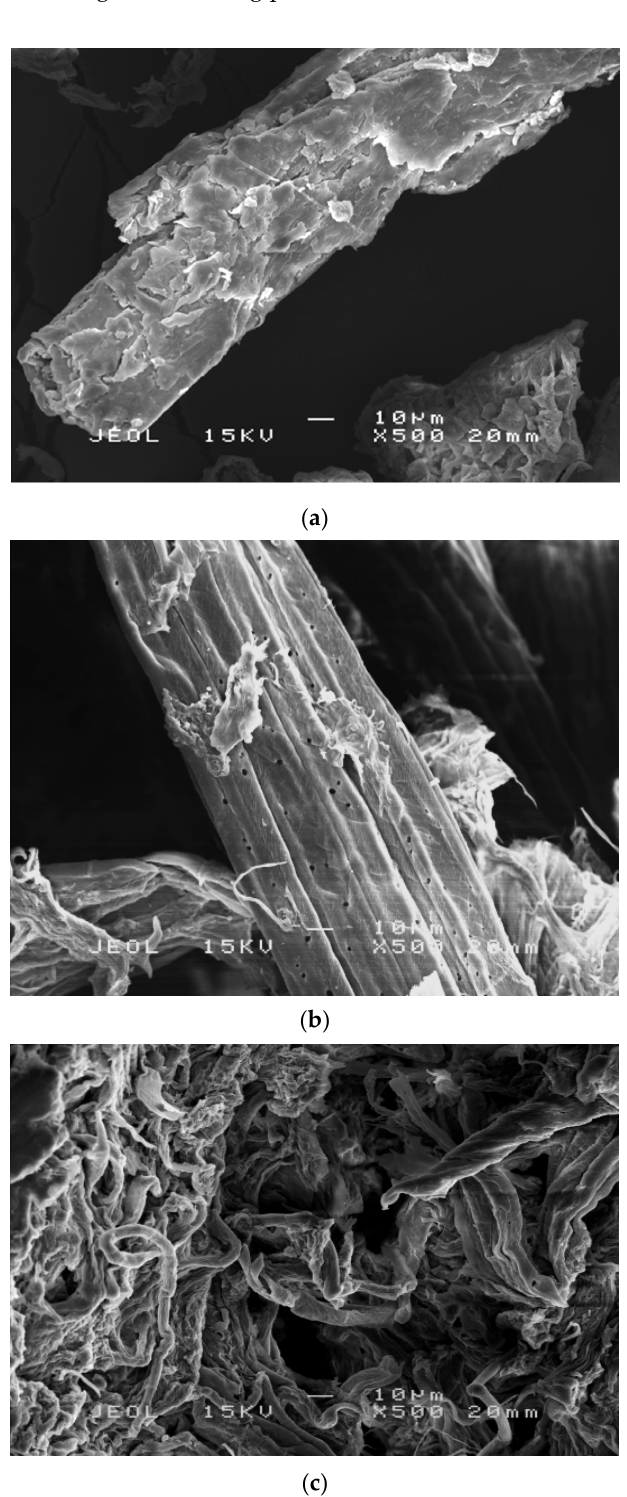
Figure 4. SEM micrographs of ( a ) raw TLWF; ( b ) alkaline-treated TLWF; and ( c ) bleached TLWF.